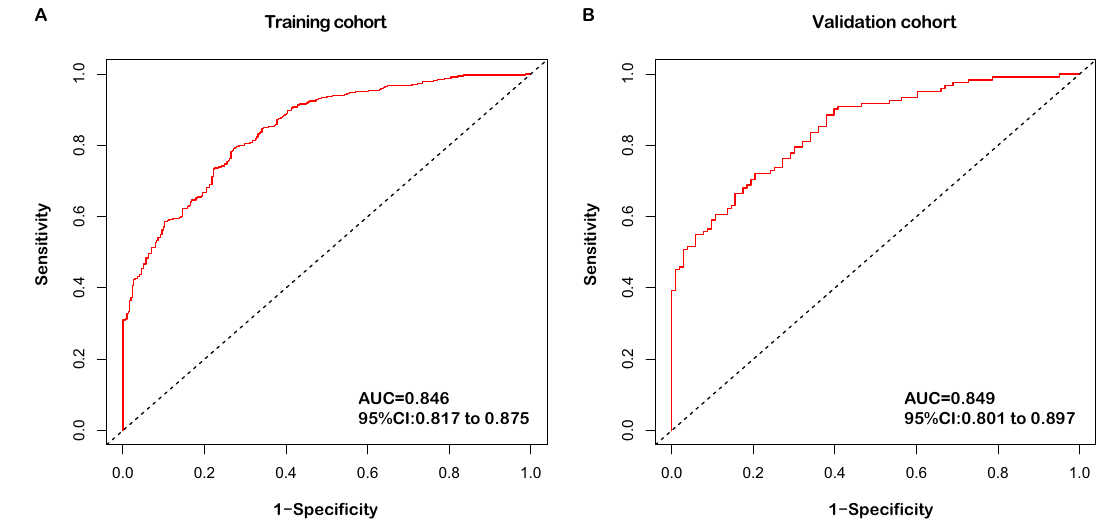
Figure 3. Receiver-operating characteristic curves (ROCs) for evaluating the performance of the nomogram- predicted probability of drainage duration of axillary suction drain ≥ 11 days in the training cohort and validation cohort. ( A ) The ROC curve in the training cohort indicates an area under the curve (AUC) of 0.846 (95% CI 0.817–0.875). ( B ) In the validation cohort, the ROC indicates an AUC of 0.849 (95% CI